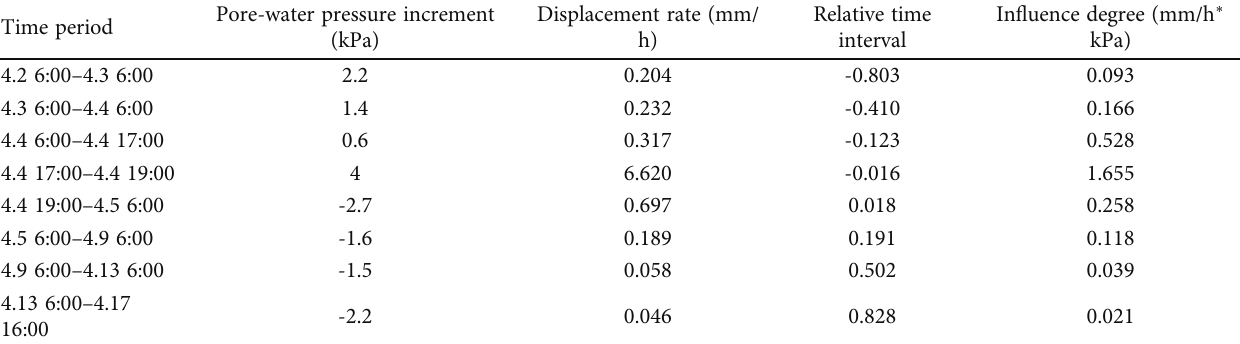
Table 2: Analysis of pore-water pressure and